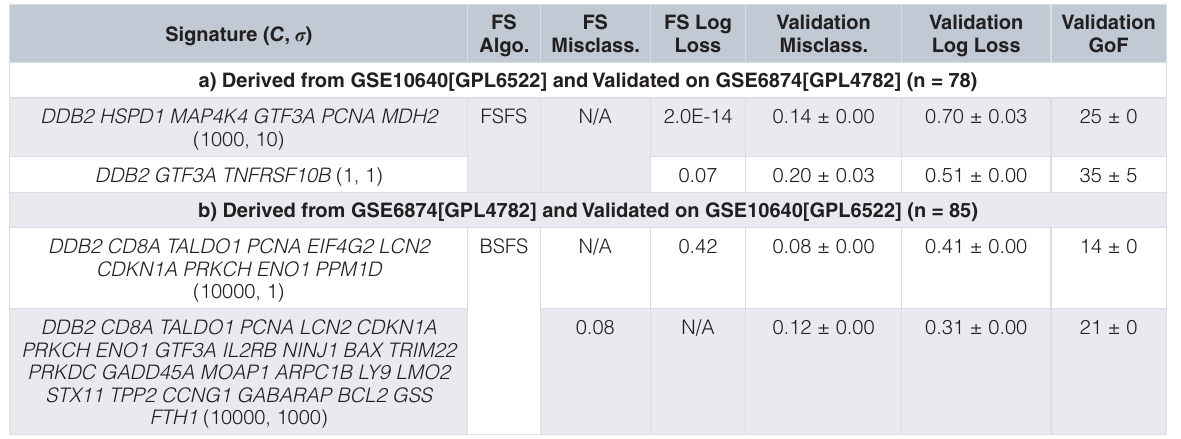
Table 3. Best performing human signatures assessed by traditional validation.